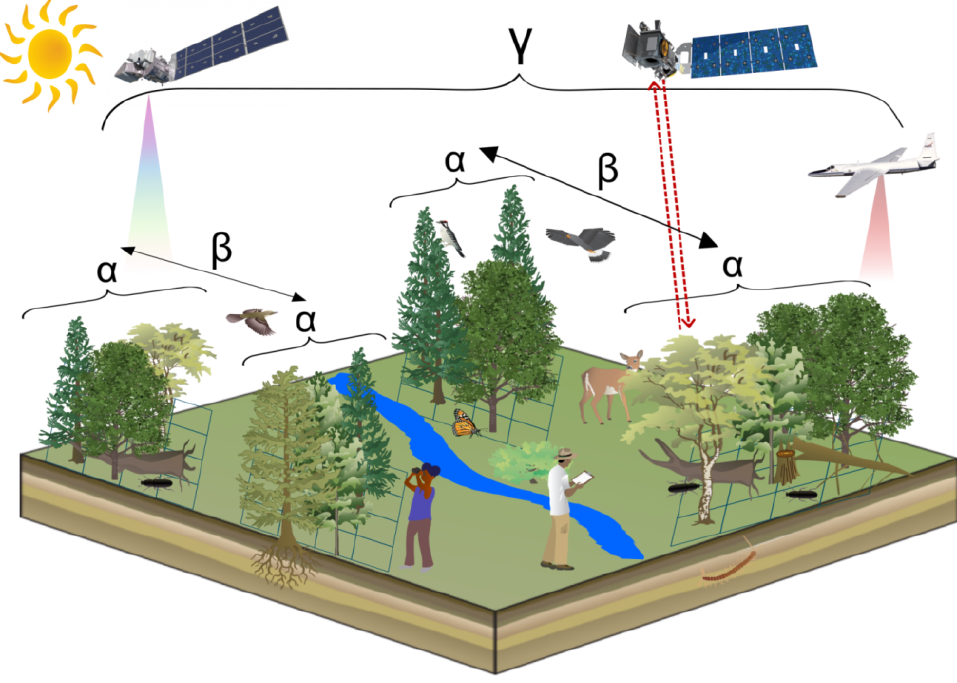
Figure 1. Overview figure depicting the different biodiversity scales ( α , β , and γ diversity) and earth observation sensors: Light detection and ranging (LiDAR) from airborne sensors; optical (left) and radar imagery (right) from satellite remote sensing. Graphics are extracted from the University of Maryland (https://ian.umces.edu/media-library/, accessed on 1 September 2022), and NASA Science (https://science.nasa.gov/get-involved/toolkits/spacecraft-icons, accessed on 1 September